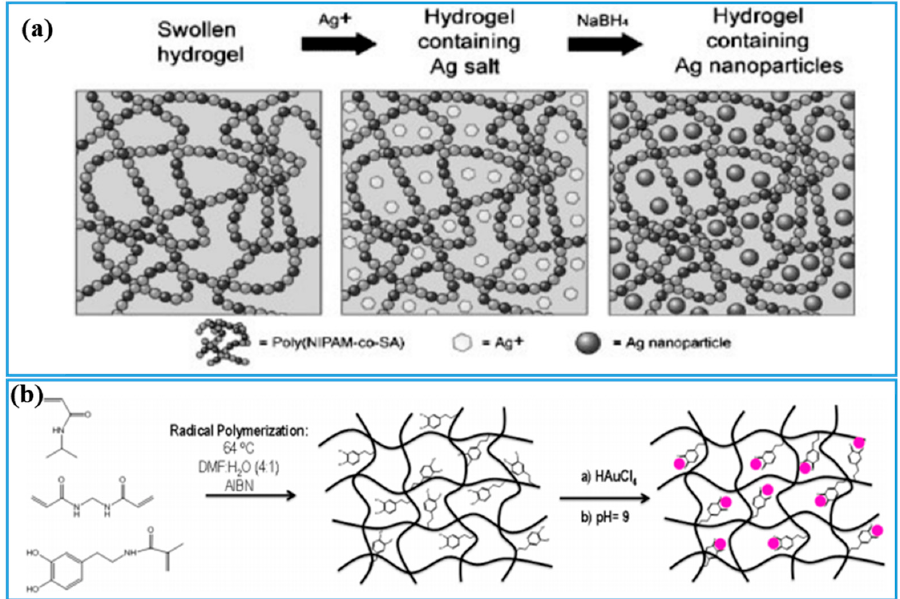
Figure 7. ( a ) Illustration of preparation process of PNIPAM-ECH with Ag nanoparticles served as conductive filler. Copyright from Ref. [125] John Wiley and Sons. ( b ) Illustration of preparation process of PNIPAM-ECH with Au nanorods served as conductive filler. Copyright from Ref. [126] ACS publications.